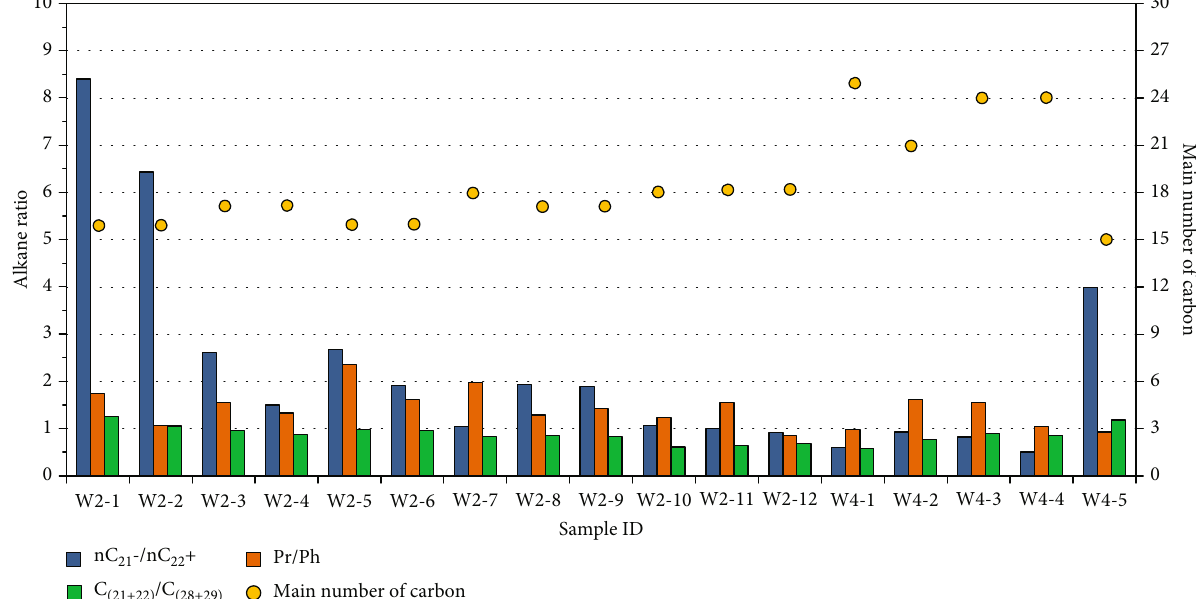
Figure 7: The characteristics of n-alkanes of the Longtan coal series